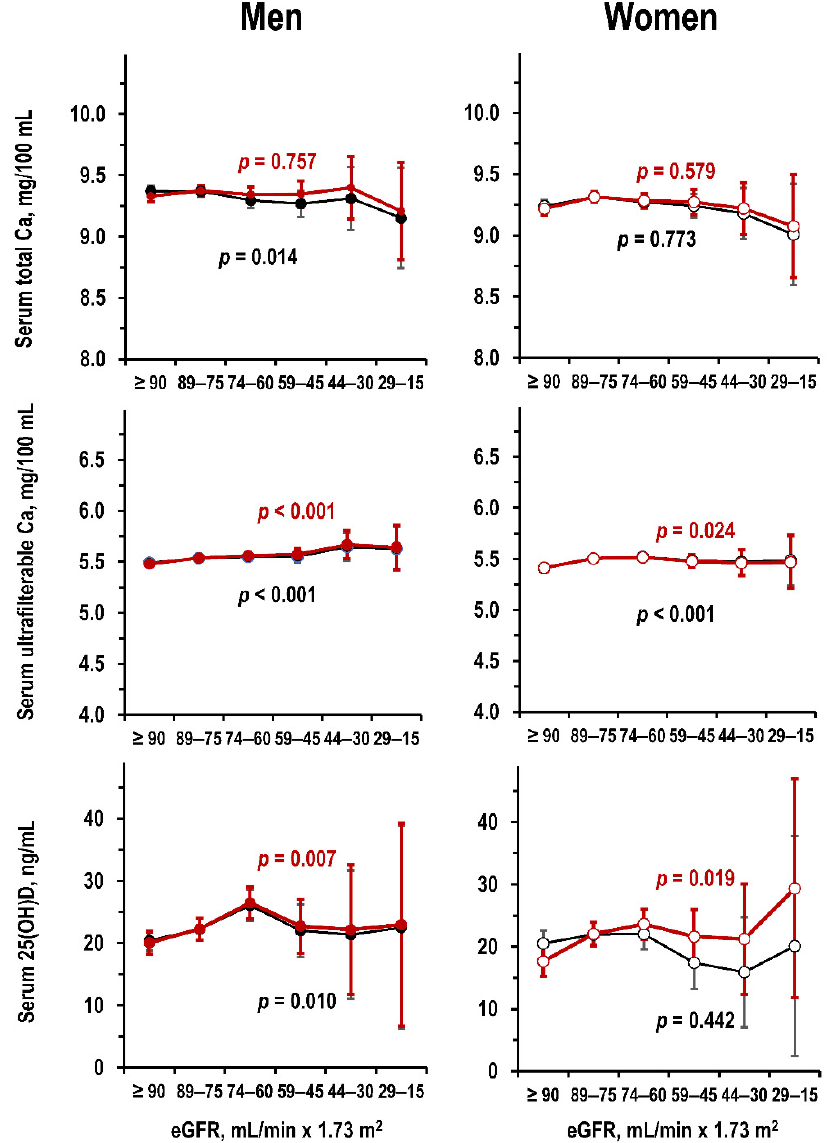
Figure 4. Moli-sanidataset: meanand95%CIinmenandwomen( left panelsand right panels,respectively) by eGFR stratum of serum total Ca ( upper panels), serum ultrafilterable Ca ( central panels), and serum 25(OH)D ( lower panels) in uni-variate ANOVA and in ANOVA controlled for age (black line and red line, respectively). Number of individuals per eGFR stratum from left to right: men = 195, 168, 88, 30, 5, and 2—women = 139, 175, 107, 36, 8, and 2. No individual had eGFR < 15 mL / min × 1.73 m 2